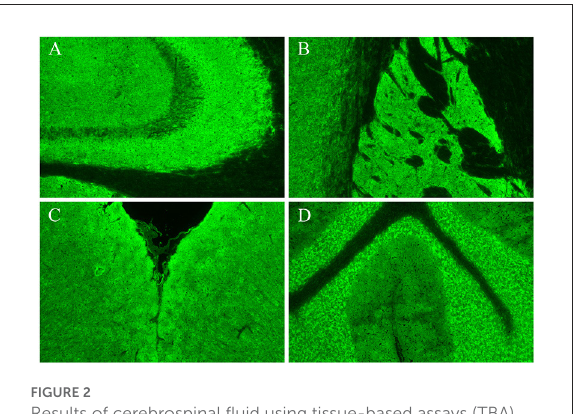
FIGURE2 Results of cerebrospinal fluid using tissue-based assays (TBA). Hippocampus (A) , striatum (B) , cerebral cortex (C) , and cerebellum (D)